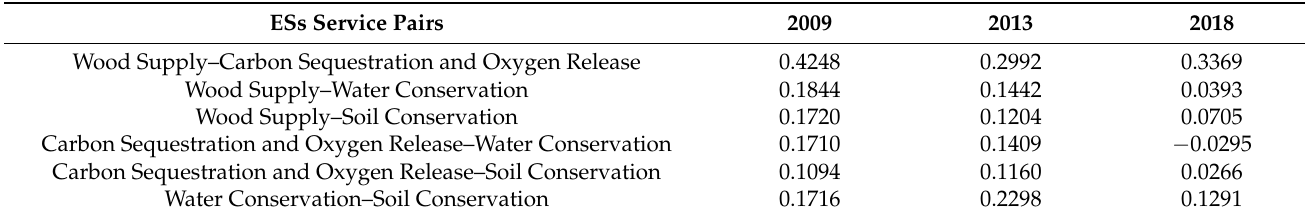
Table 1. Bivariate local autocorrelation Moran I index of ESs in PM plantations in Paiyangshan Forest